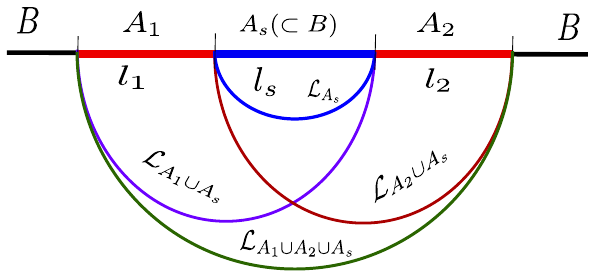
Fig. 3 Geodesics in a bulk AdS 3 anchored on different subsystems in the dual boundary CFT 1 + 1